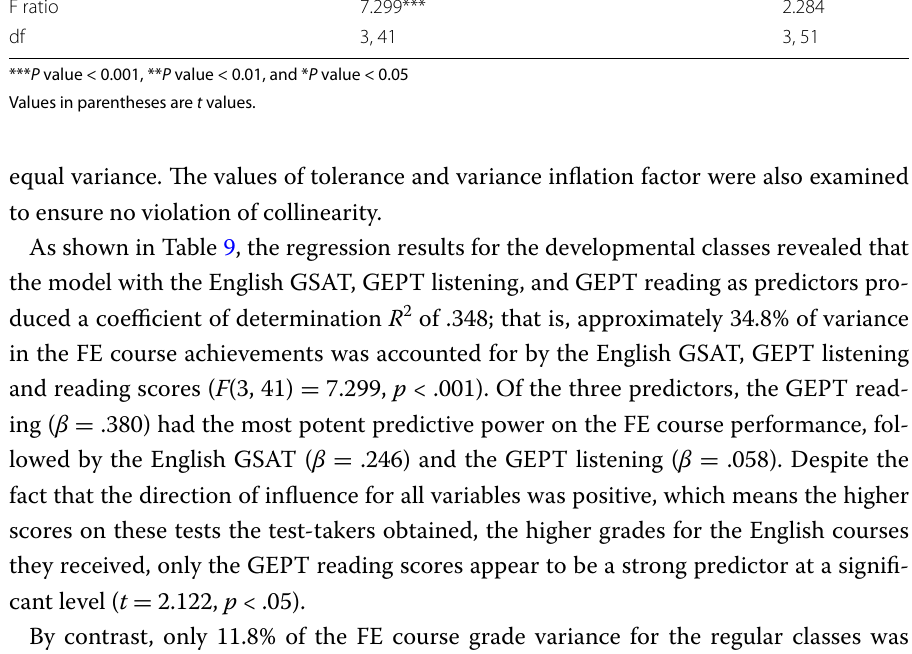
*** P value < 0.001, ** P value < 0.01, and * P value < 0.05 Values in parentheses are t